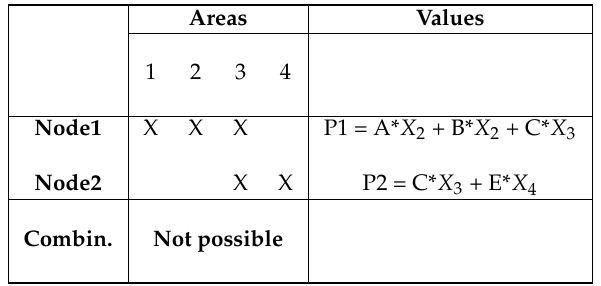
Table 3. CS: combination of data not possible because projected data overlap according to the boolean